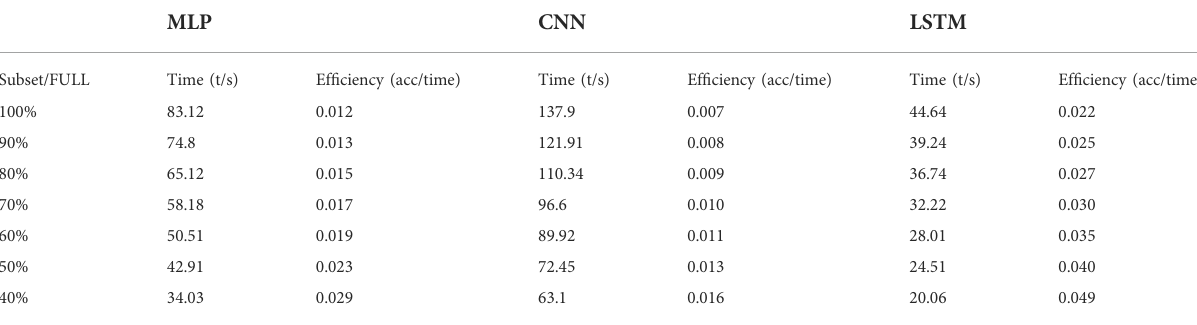
TABLE 2 Time and Ef fi ciency of subsets with different